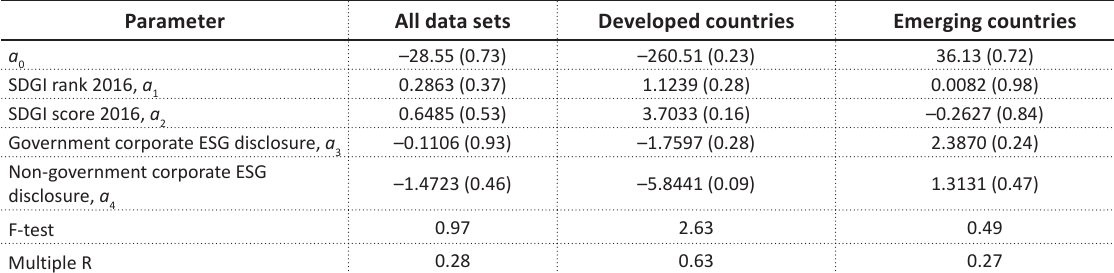
Table 7. Multiple regression analysis: ranking in 50 largest economies ( Y ) and SDGI ranking and ESG disclosure regulation ( X )